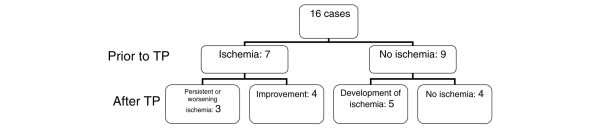
Evolution of limbs and/or cutaneous ischemia after terlipressin (TP) treatment.